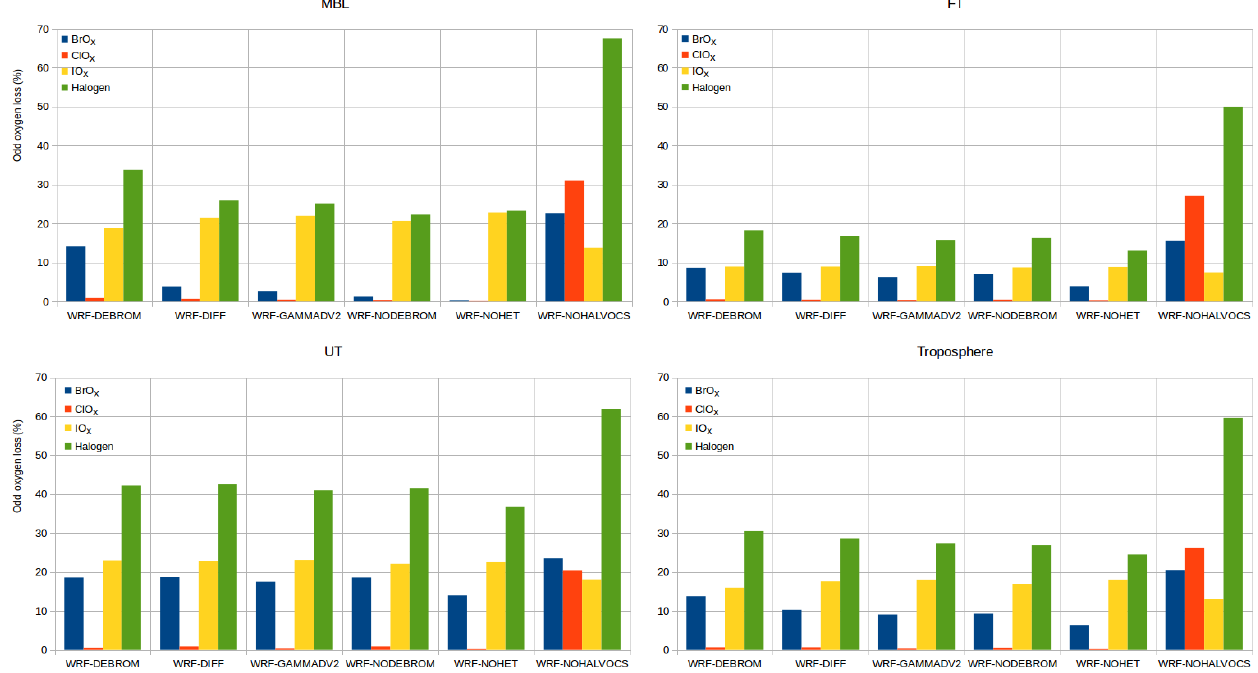
Figure 15. Integrated odd oxygen loss rates for each O 3 depleting halogen family within the troposphere at different altitude levels: MBL (surface–900hPa), FT (900–350hPa), UT (350hPa–tropopause) and troposphere (surface–tropopause) for the WRF-DEBROM, WRF- GAMMADV2, WRF-DIFF, WRF-NODEBROM, WRF-NOHET and WRF-NOHALVOCS